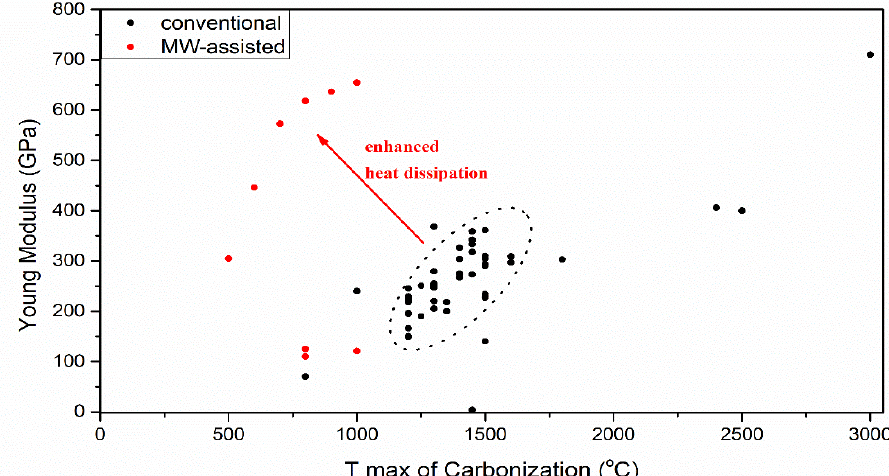
Figure 9. Dependence of Young modulus on maximum temperature of carbonization based on literature data presented in Figure 3.